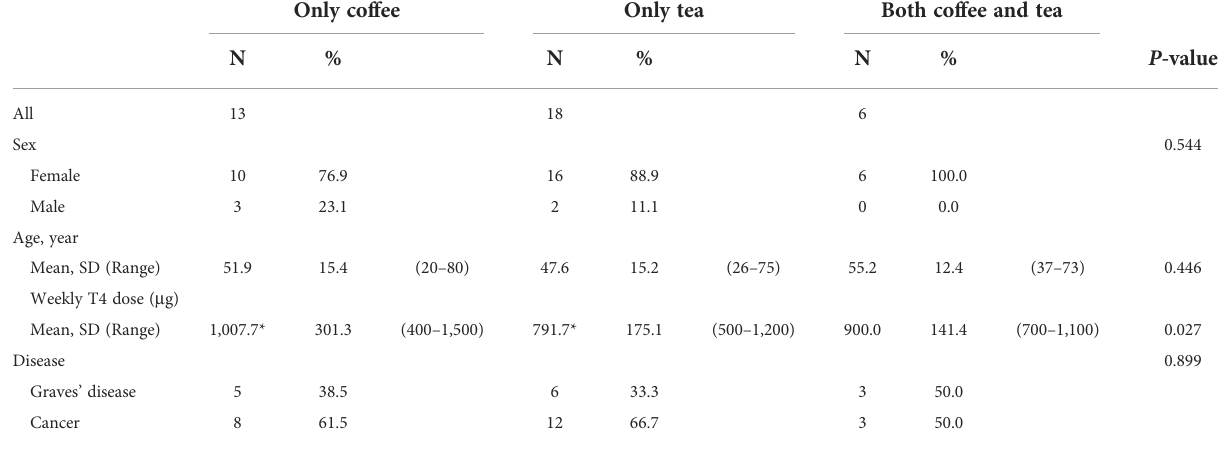
TABLE 1 Demographic data of the